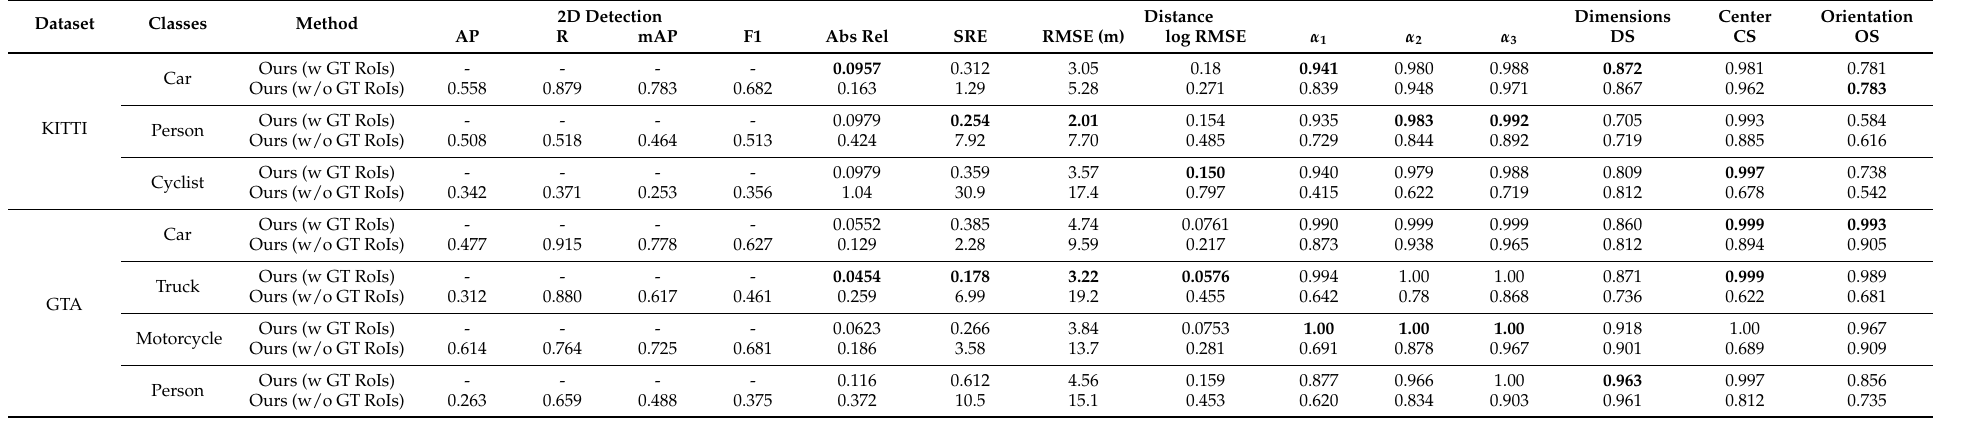
Table 2. Our experimental results for different object classes on both KITTI and GTAV datasets. The evaluation was performed on the validation split of the datasets. Since accuracy metrics for the 2D detection (RoI) were not available for [11], only ours are displayed. The bold numbers represent the best score for each metrics for each dataset.